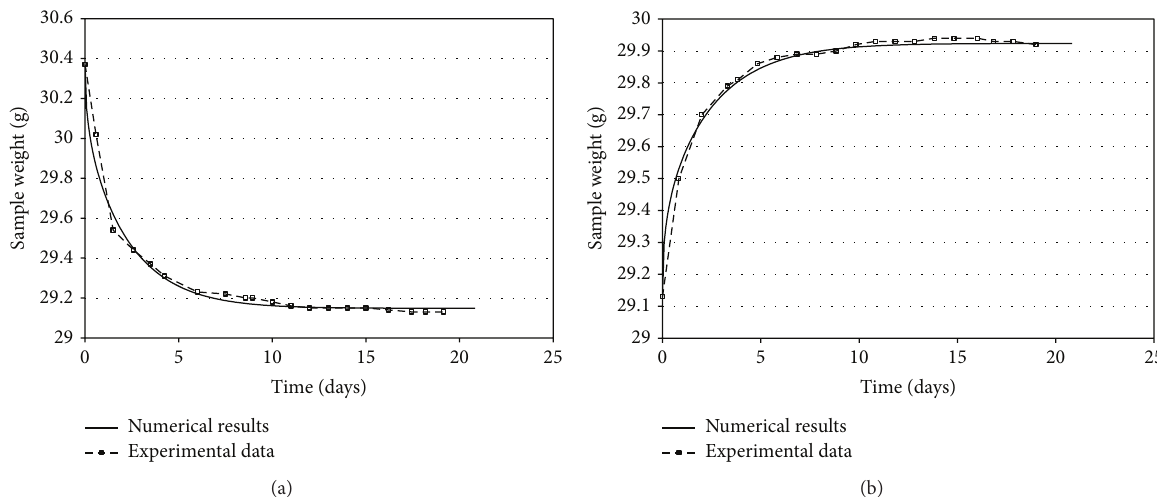
Figure 5: (a) Experimental results and the numerical prediction of the weight evolution of the sample D1 during dehydration while the relative humidity (RH) decreases from 75% to 32% (b) and during hydration with the increase of RH from 32% to